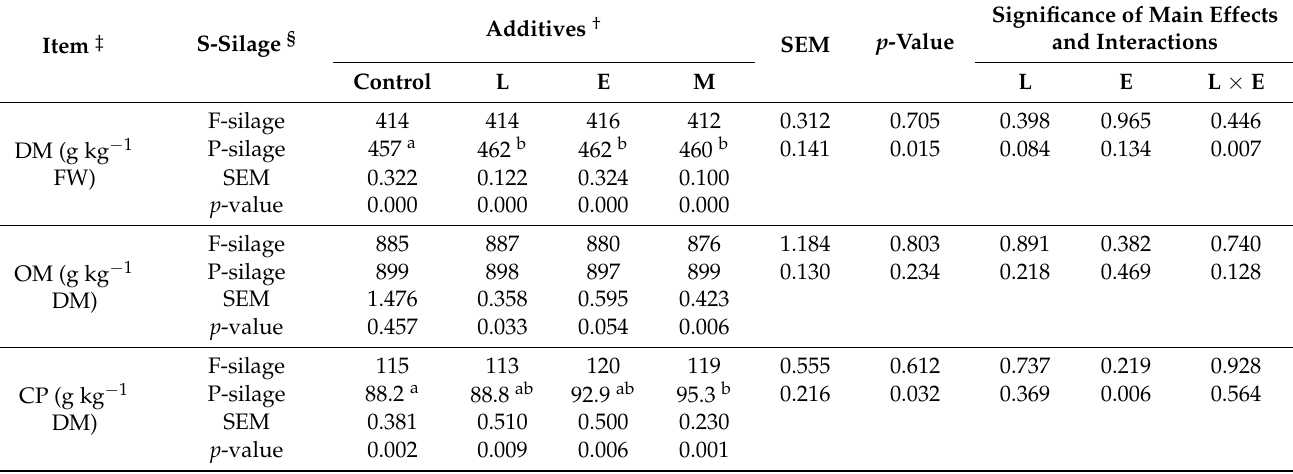
Table 4. Chemical composition of spent mushroom substrate silages prepared with lactic acid bacteria and